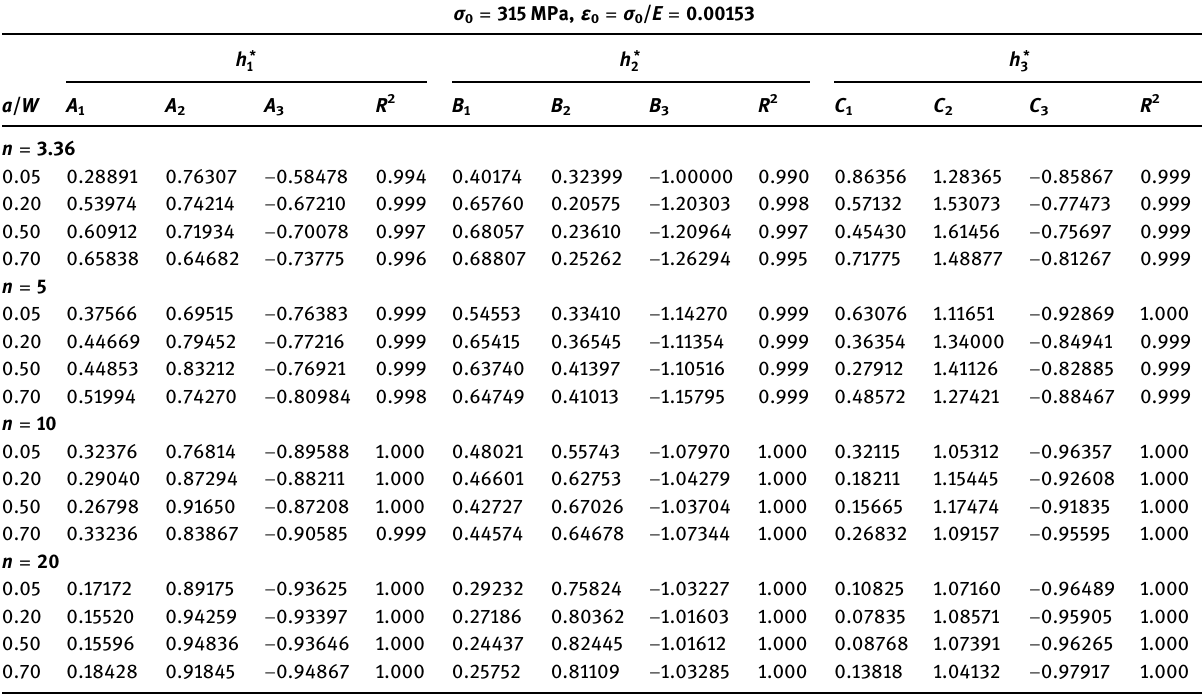
Table 2: Coe ffi cients of matching equations ( 11 – 13 ) to the obtained numerical results for materials described with the yield point σ = 315 0